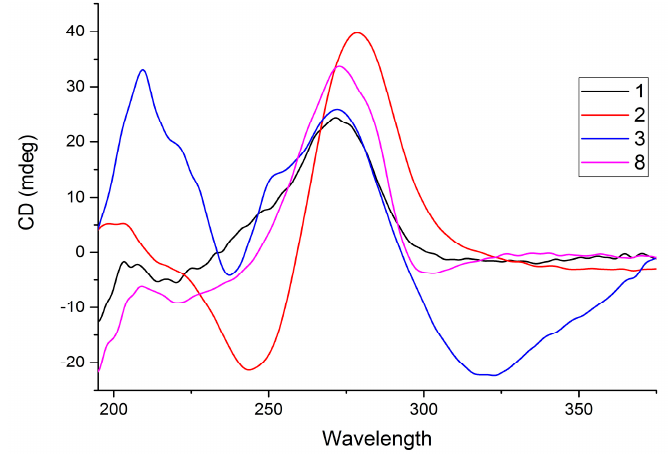
Figure 3. CD spectra for compounds 1 – 3 and 8 (in acetonitrile).